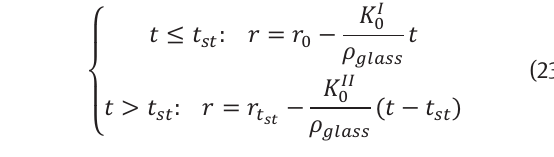
Figure 5: Modelled radius reduction in R-glass fibers after treatment in water at various times at 60°C.